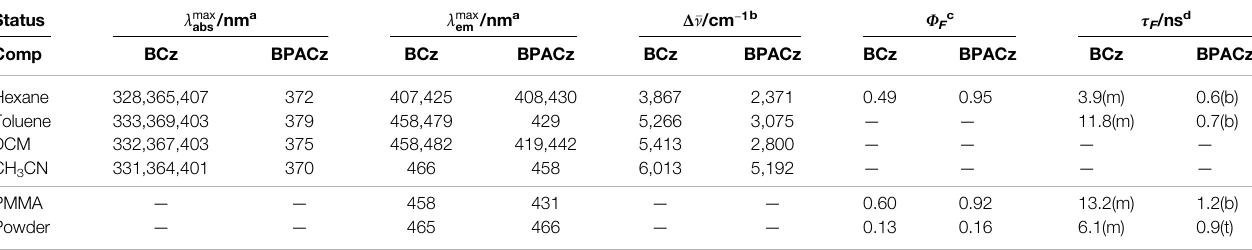
TABLE 1 | Photophysical properties of BCz and BPACz in different status: four solutions (hexane, toluene, DCM, MeCN); PMMA (polymethylmethacrylate) fi lm; pristine powder. Maximum of absorption and emission ( λ abs , λ em ), PL quantum yield and lifetime ( Φ F , τ F ), stokes shift Δ (cid:1) ] .